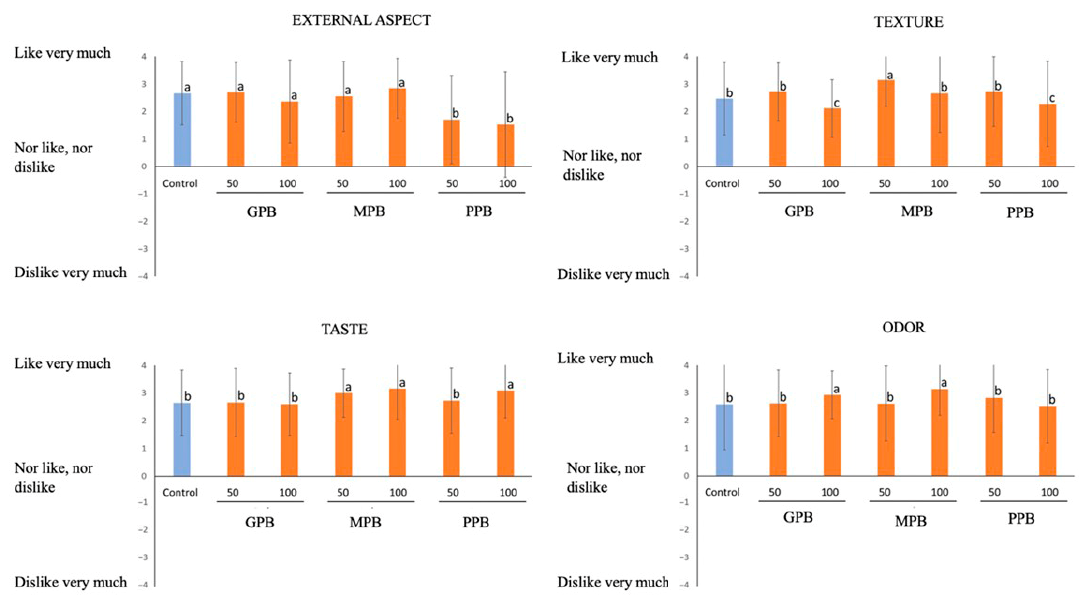
Figure 3. Results obtained in sensory evaluation of reformulated burgers with pumpkin oil. Different letters in the columns show significant differences ( p < 0.05). Control: Deer meat (78.8%), pork fat (19%), corn-starch (1.4%), spices (0.8%); GPB 50: Pork fat (9.5%), gel emulsion (9.5%); GPB 100: Gel emulsion (19%); PPB 50: Pork fat (9.5%), particle emulsion (9.5%); PPB 100: Particle emulsion (19%); MPB 50: Pork fat (9.5%), maltodextrin emulsion (9.5%); MPB 100: Maltodextrin emulsion (19%). The rest of ingredients in the burgers are the same as the control.